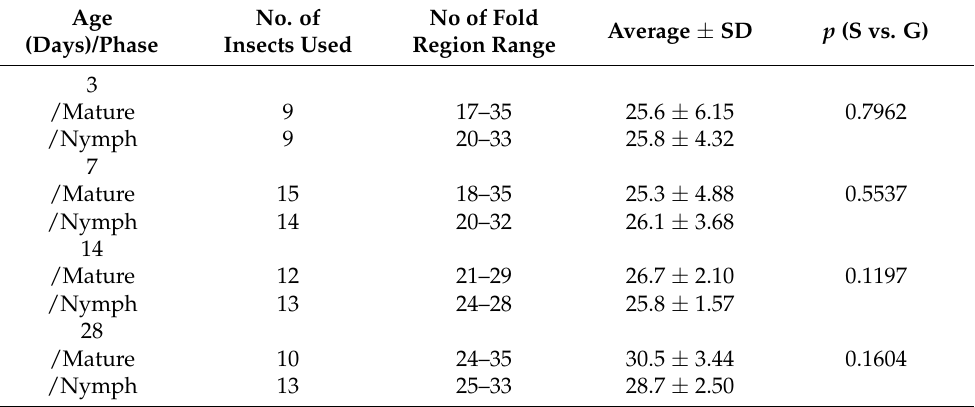
The asterisk indicates the significant difference at p < 0.05. Table 7. The number of fold region of seminal vesicle compared between adult males that received the pheromone from mature adults (Mature) and from nymphs (Nymph) in the desert locust Schisto- cerca gregaria